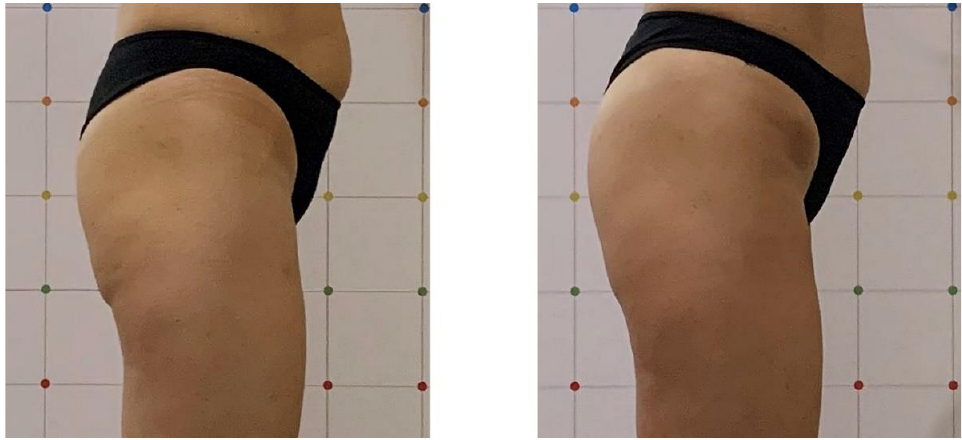
Figure 2. Right lateral view of a female patient before and 1 month after treatment. A good aesthetic improvement in buttocks muscle tone can be observed in the treated area.